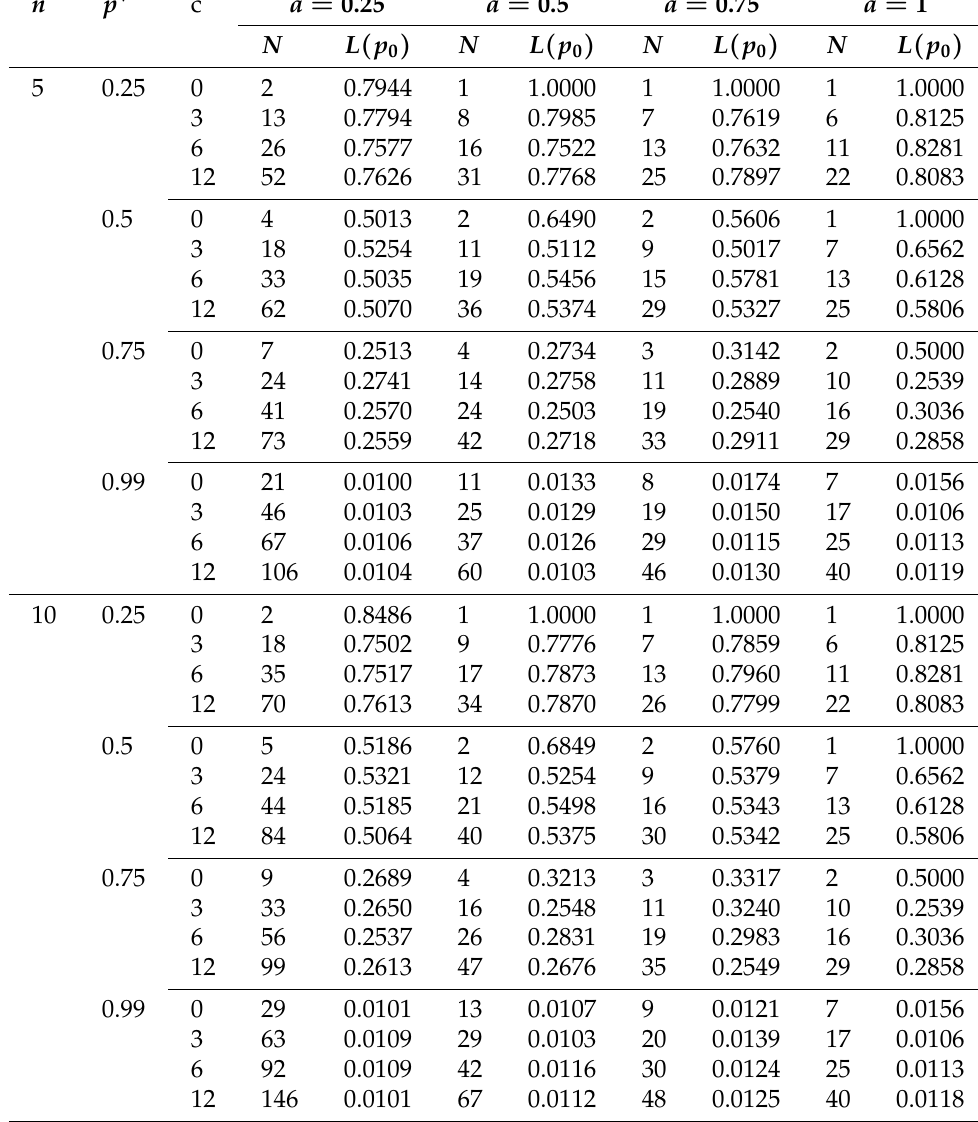
Table 3. Numerical outcomes of a single sampling plan for FB model at combination